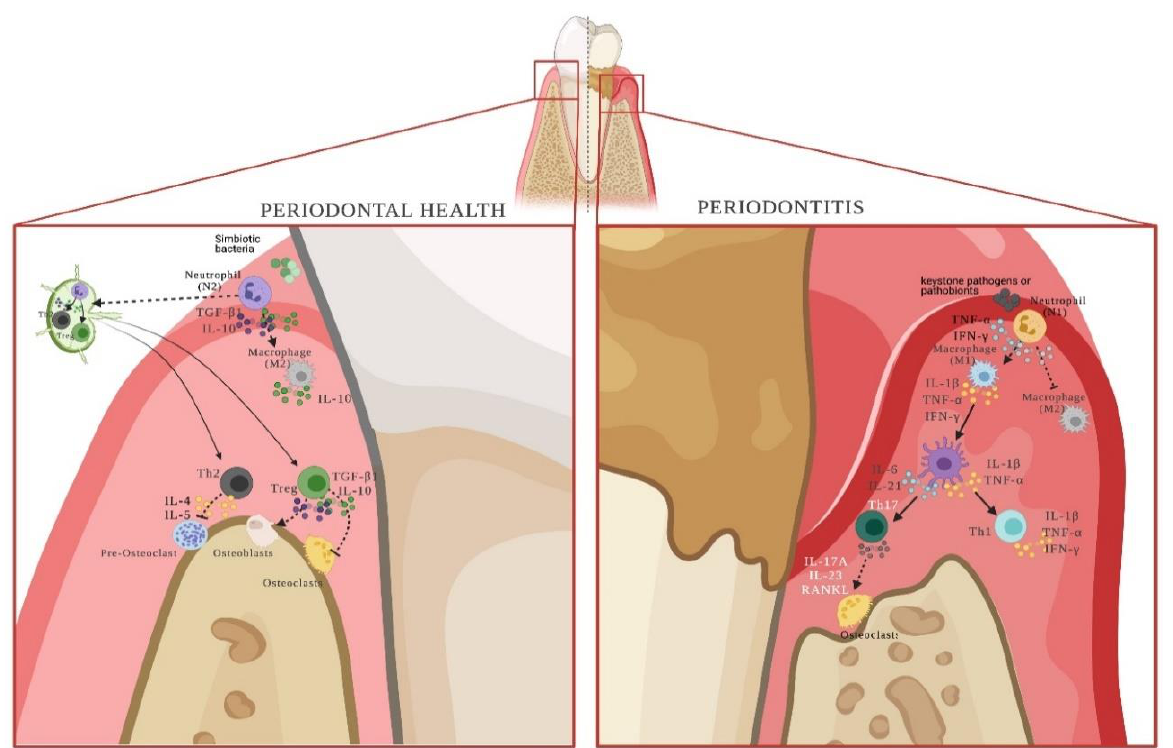
Figure 3. N1 and N2 neutrophils and their role during periodontal health or disease. Neutrophils, by recognizing symbiotic bacteria, have the ability to differentiate into the N2 phenotype. Cytokines produced by N2 cells will polarize macrophages towards M2-anti-inflammatory subsets. In